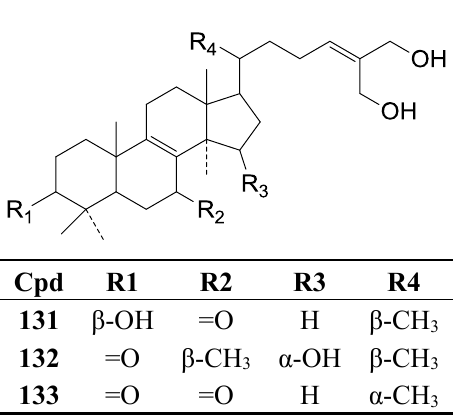
Figure 12. Structures of compounds 131 ‒ 133 .